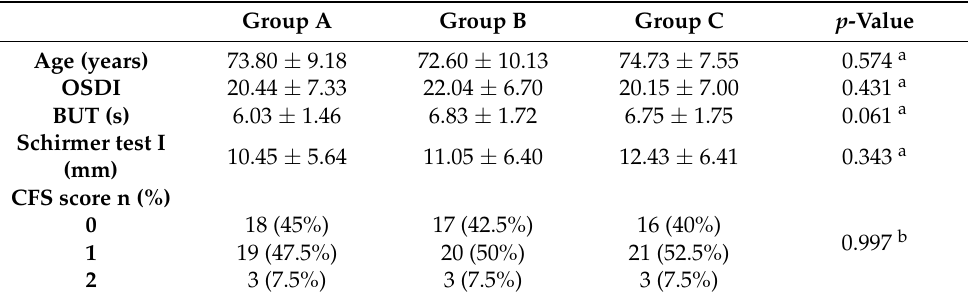
Table 1. Preoperative data of enrolled patients.